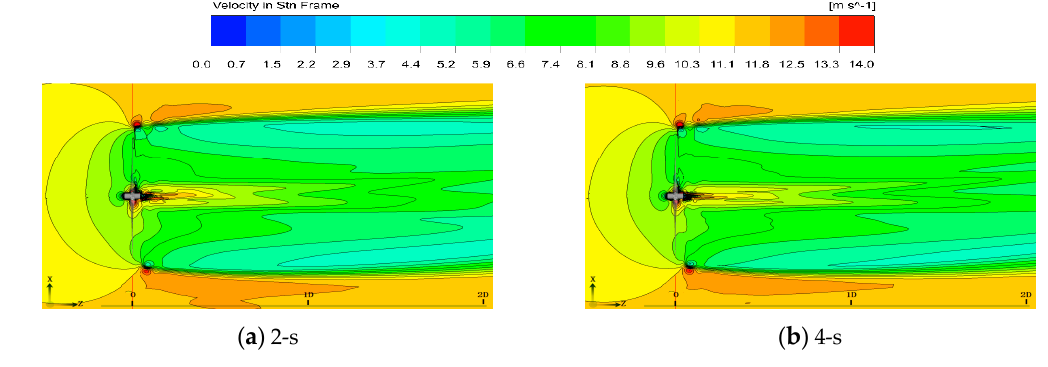
Figure 19. Velocity contours for Case 1.